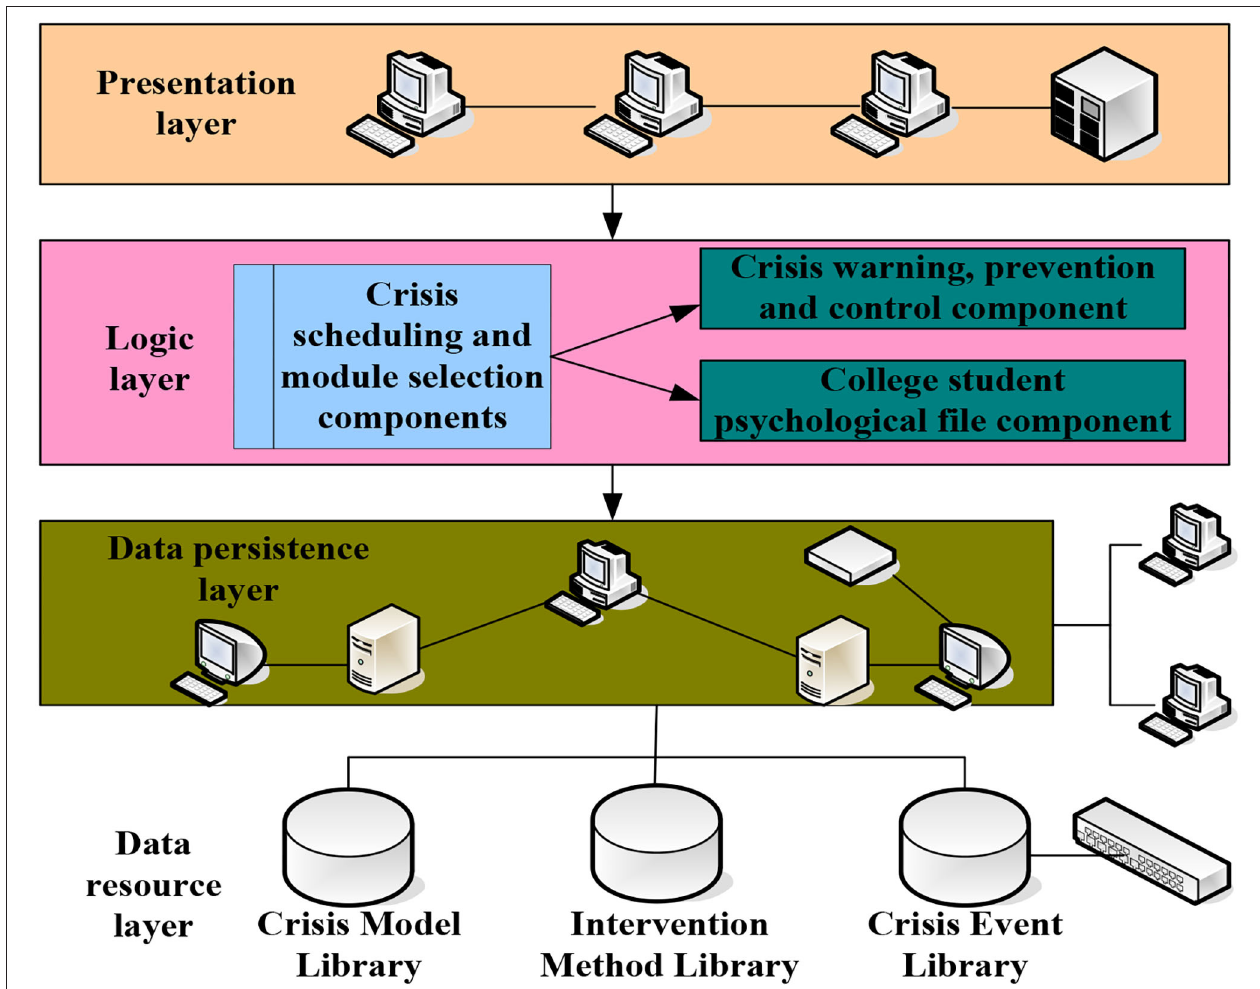
FIGURE 2 | The logical structure of the early warning